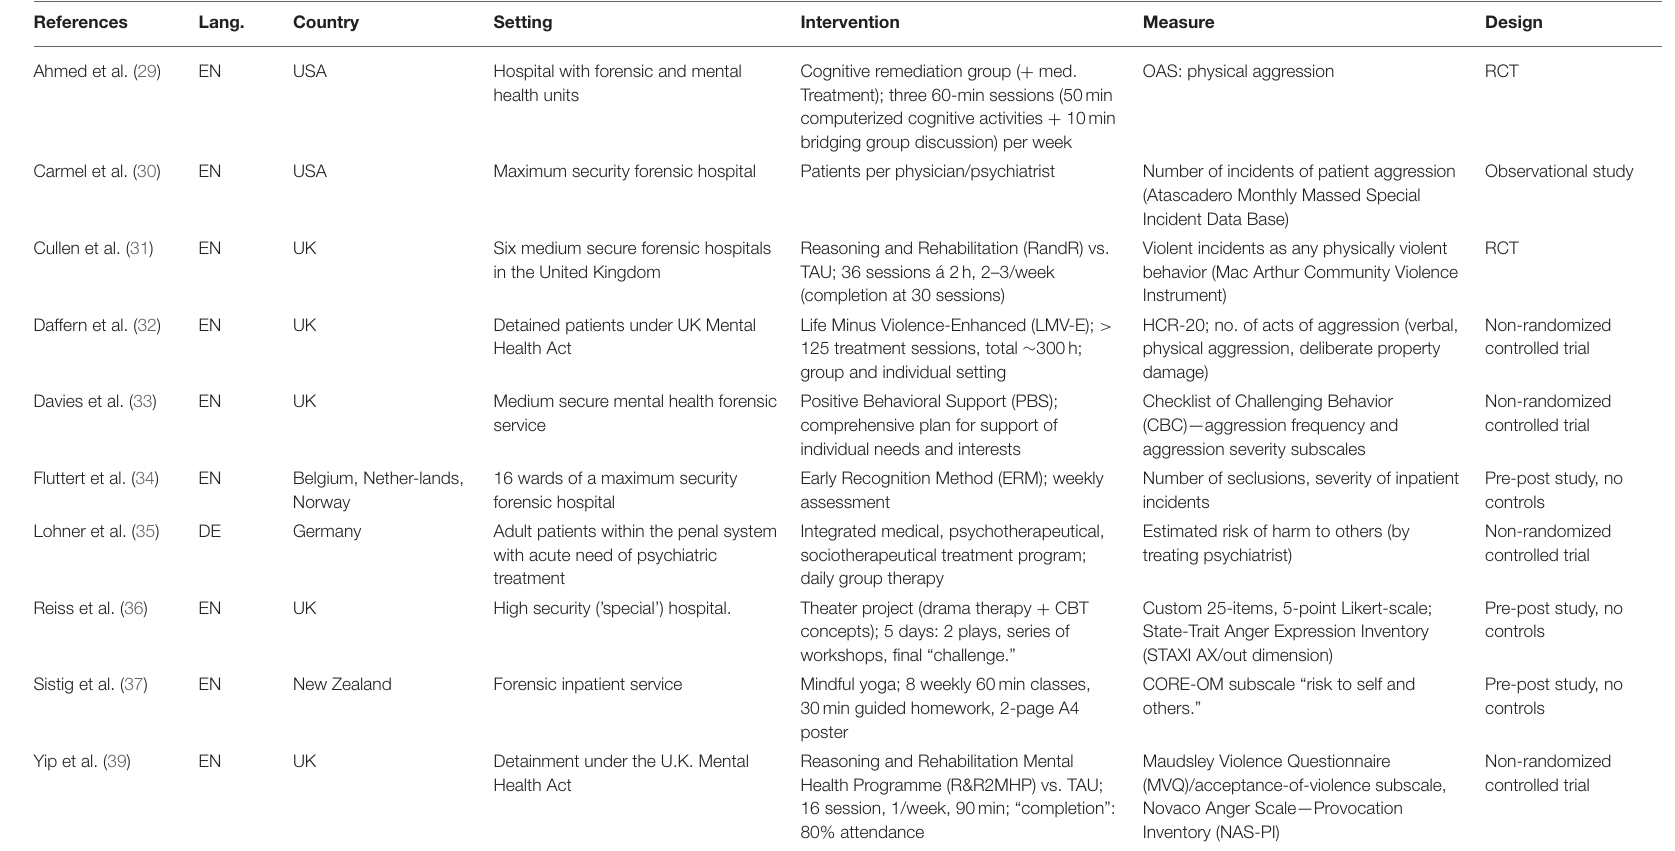
TABLE 1 | Description of the papers